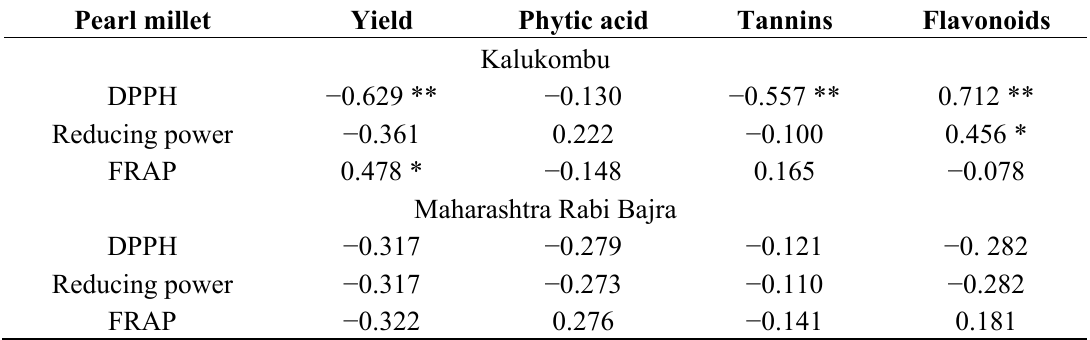
Table 4. Correlation of yield and antioxidant components with antioxidant activity of two pearl millet